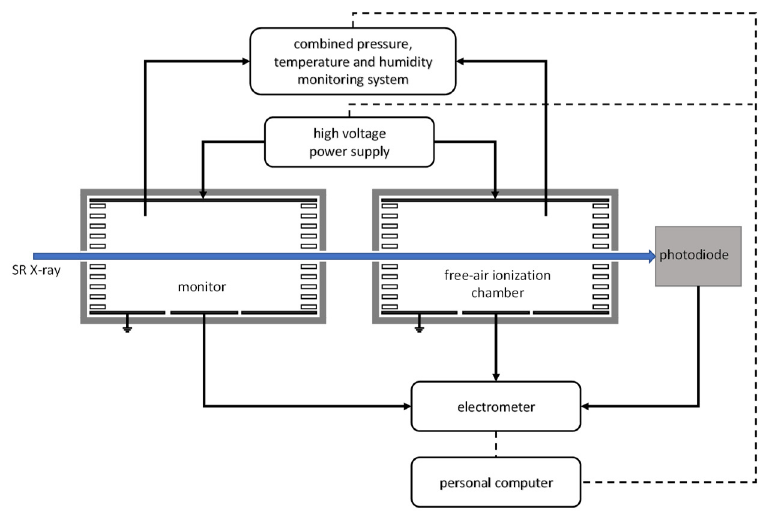
Figure 7. Schematics of the absolute radiant power measurement and calibration system using the